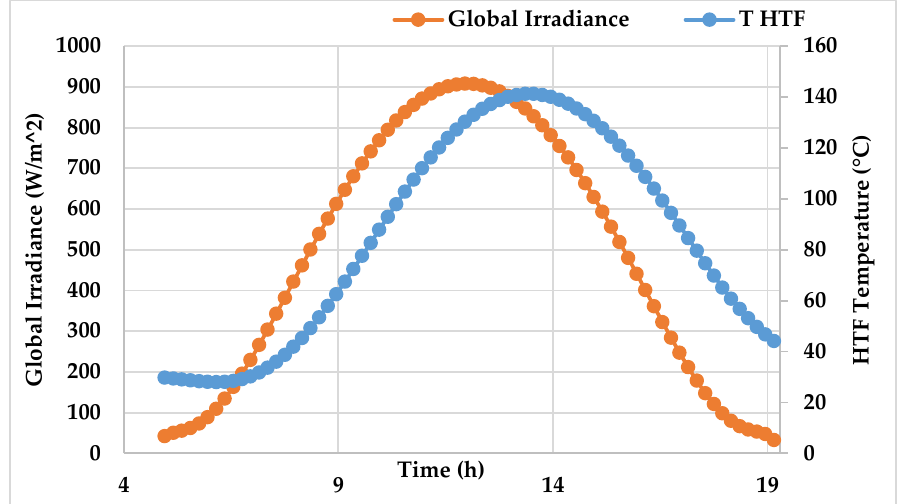
Figure 7. The HTF temperature and the global irradiance hourly variation, on 21 June. The HTF hourly variation of temperature is affected by global irradiance. The inci- dent heat energy is absorbed by the HTF and transferred to the refrigerant. The greatest temperature generated by the HTF is 141 °C between 01:00 and 03:00 pm.